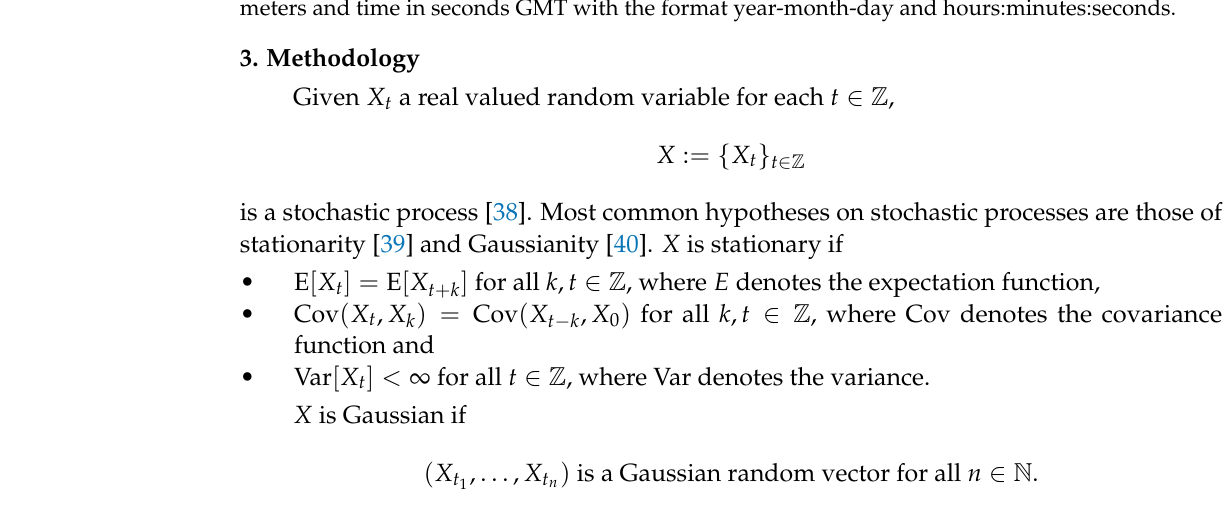
Figure 2. Left panel : representation of the 10 5 first recordings, including unobserved (missing) data, of the time series associated to buoy 433. The nine observed voids represent unobserved data. Right panel : representation of the first segment of the time series in the left panel. Sea surface elevation in meters and time in seconds GMT with the format year-month-day and